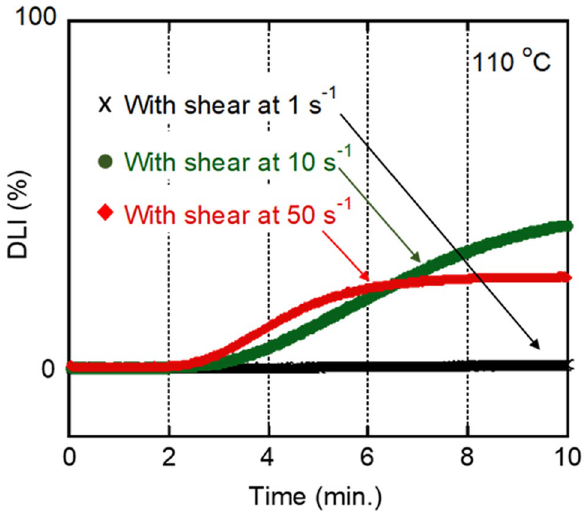
Figure 9. Growth curves of depolarized light intensity (DLI) during the isothermal process with applied shear history during cooling at 10 °C min −1 . The shear history was applied from 180 to 110 °C at 1, 10, and 50 s −1 , then held at 110 °C for 10